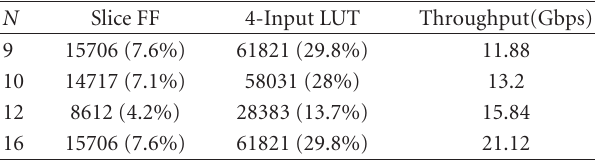
Table 4: Throughput and hardware requirements for representative